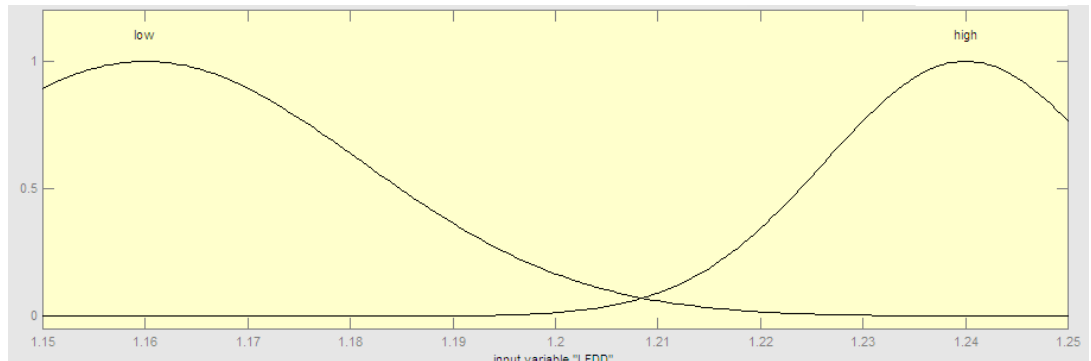
Figure 6. Input membership functions for the input variable, which is the linear fractal dimension of death cases (LFDD).